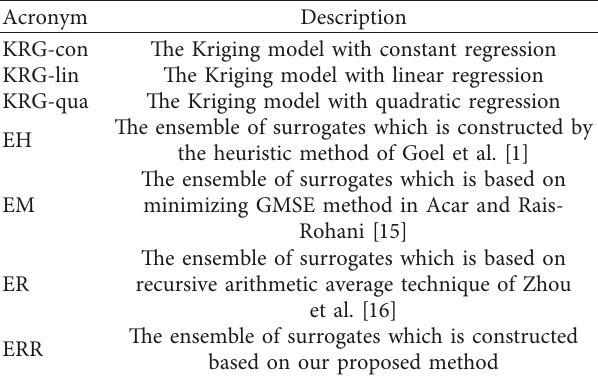
Table 2: Summary of surrogate modeling strategies.